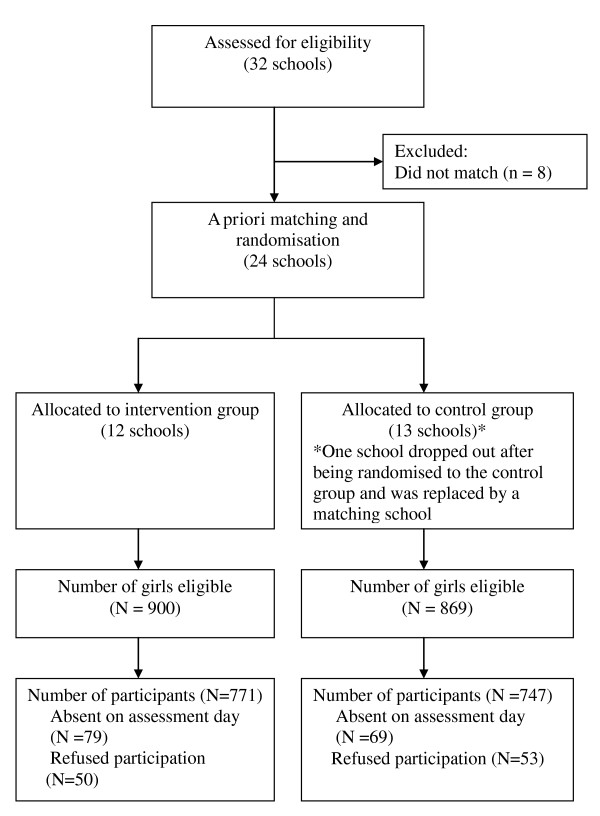
Flow of schools and participants through the trial.